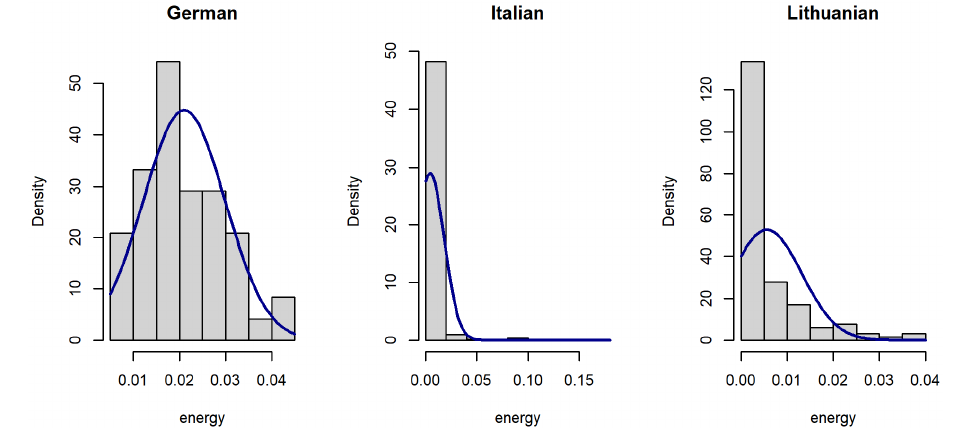
Figure 1. Histograms of voice signal energy in datasets.